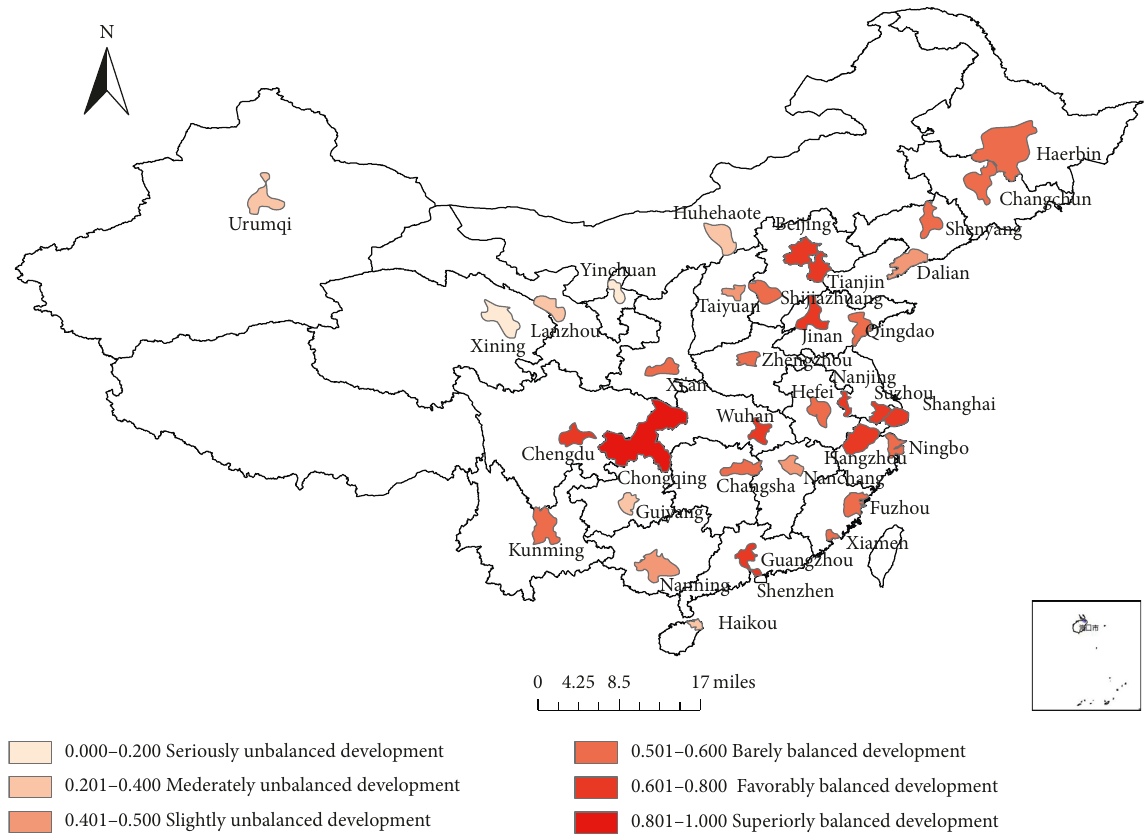
Figure 7: Spatial distribution of CCD in UPE, economy, and population in